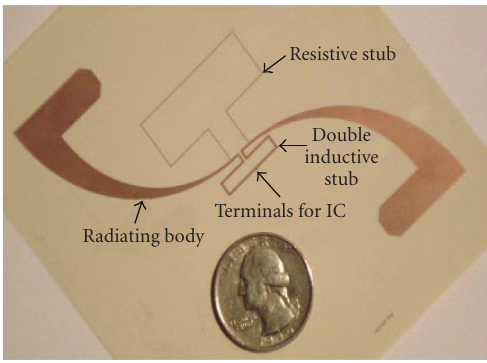
Figure 1: RFID tag on LCP.